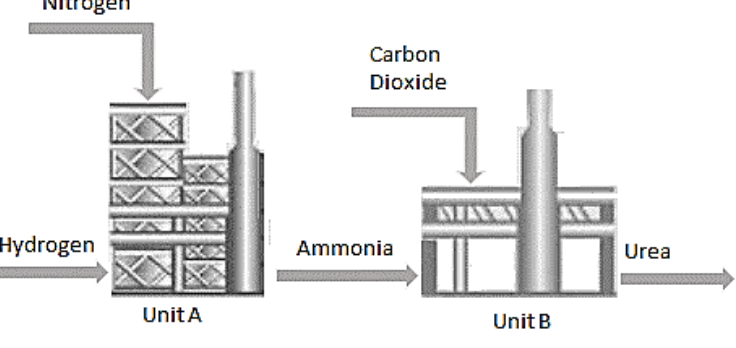
Figure 4. The flowchart of urea production.